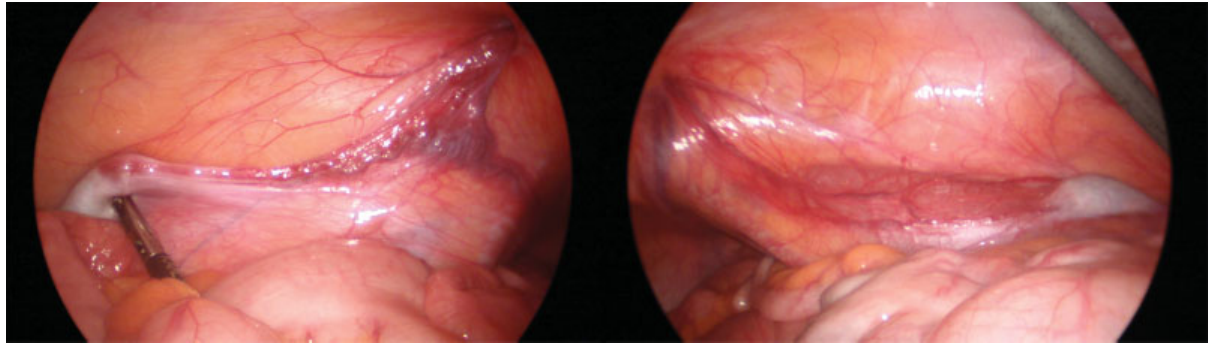
Fig. 3 Laparoscopy: testis on the psoas muscle abutting the lower pole of the